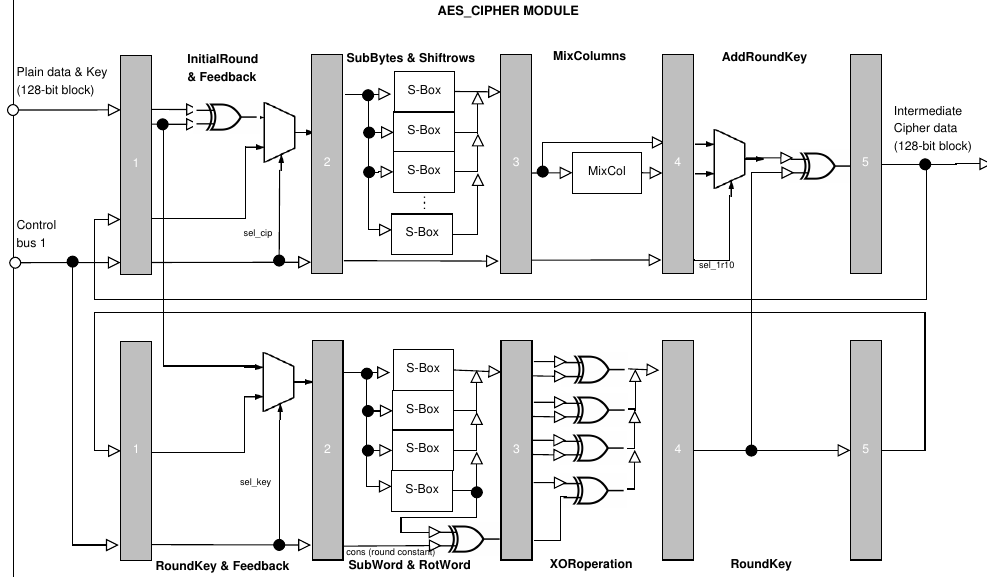
Figure 2. Block diagram of the AES Cipher